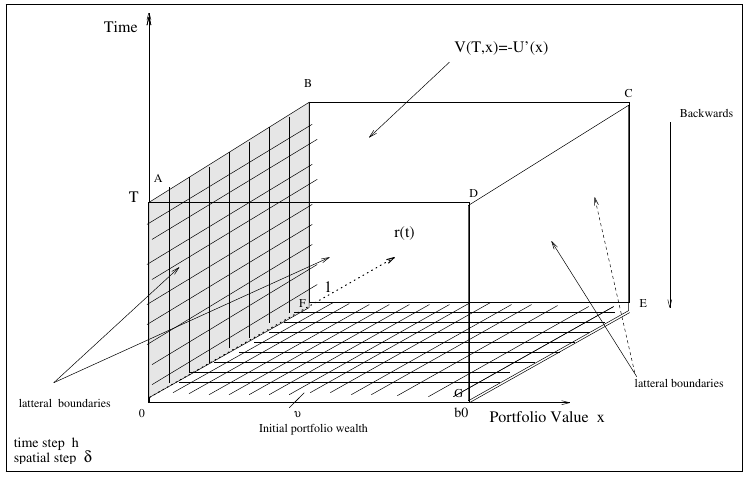
Figure 1. The Dynamic programming procedure.